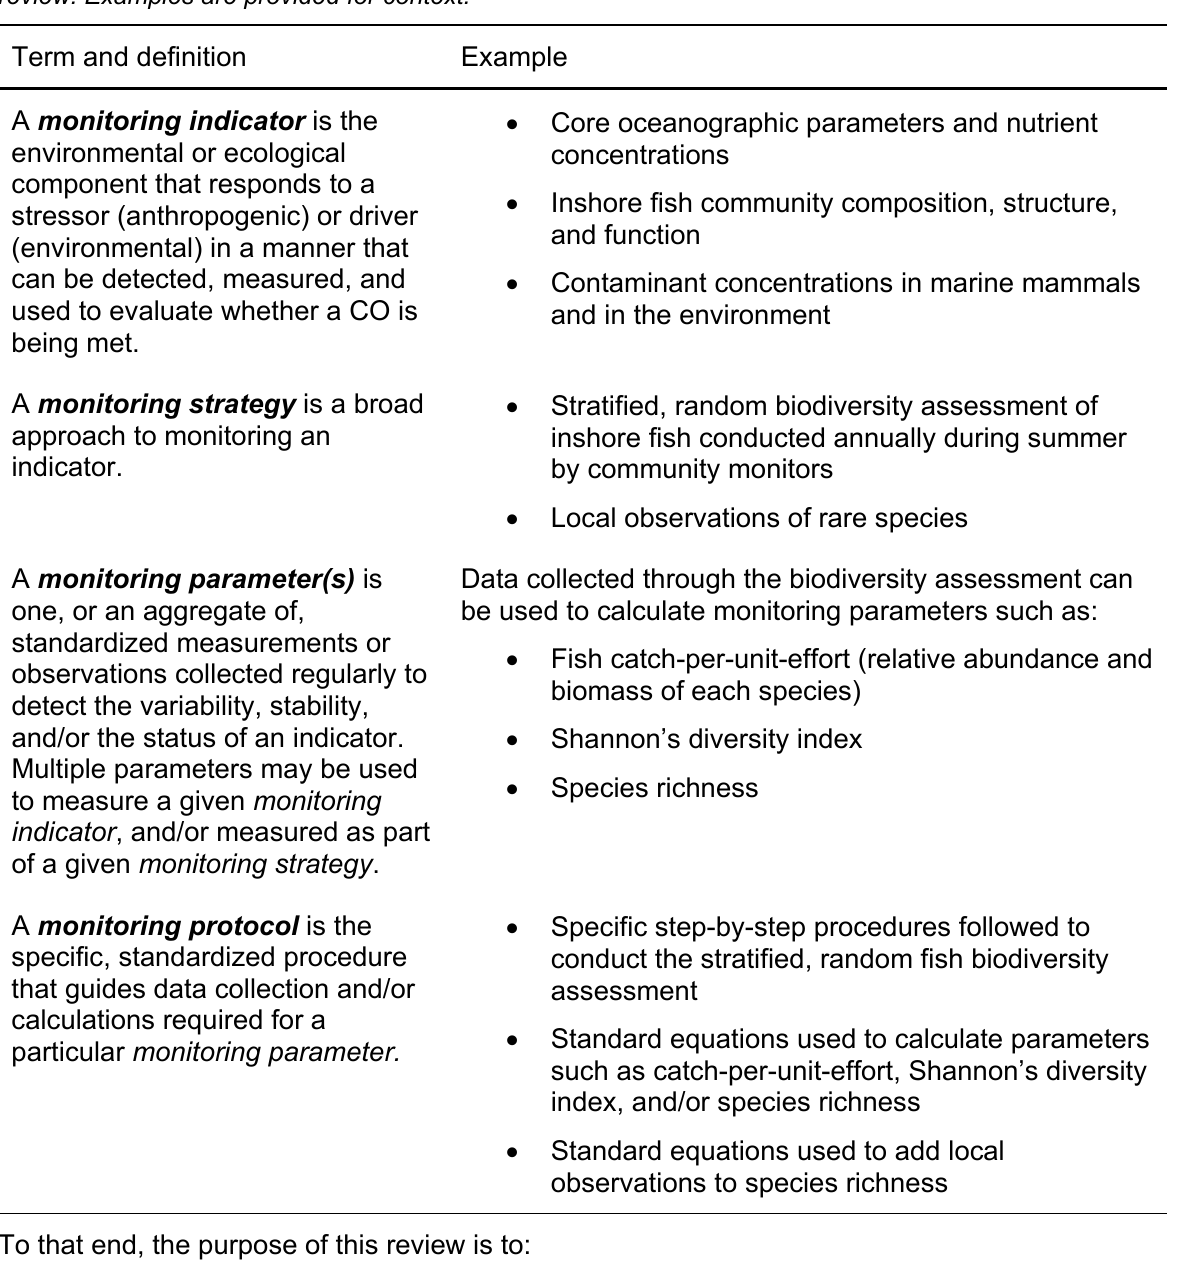
Table 1. Terms and definitions used to describe components of a monitoring program throughout the review. Examples are provided for